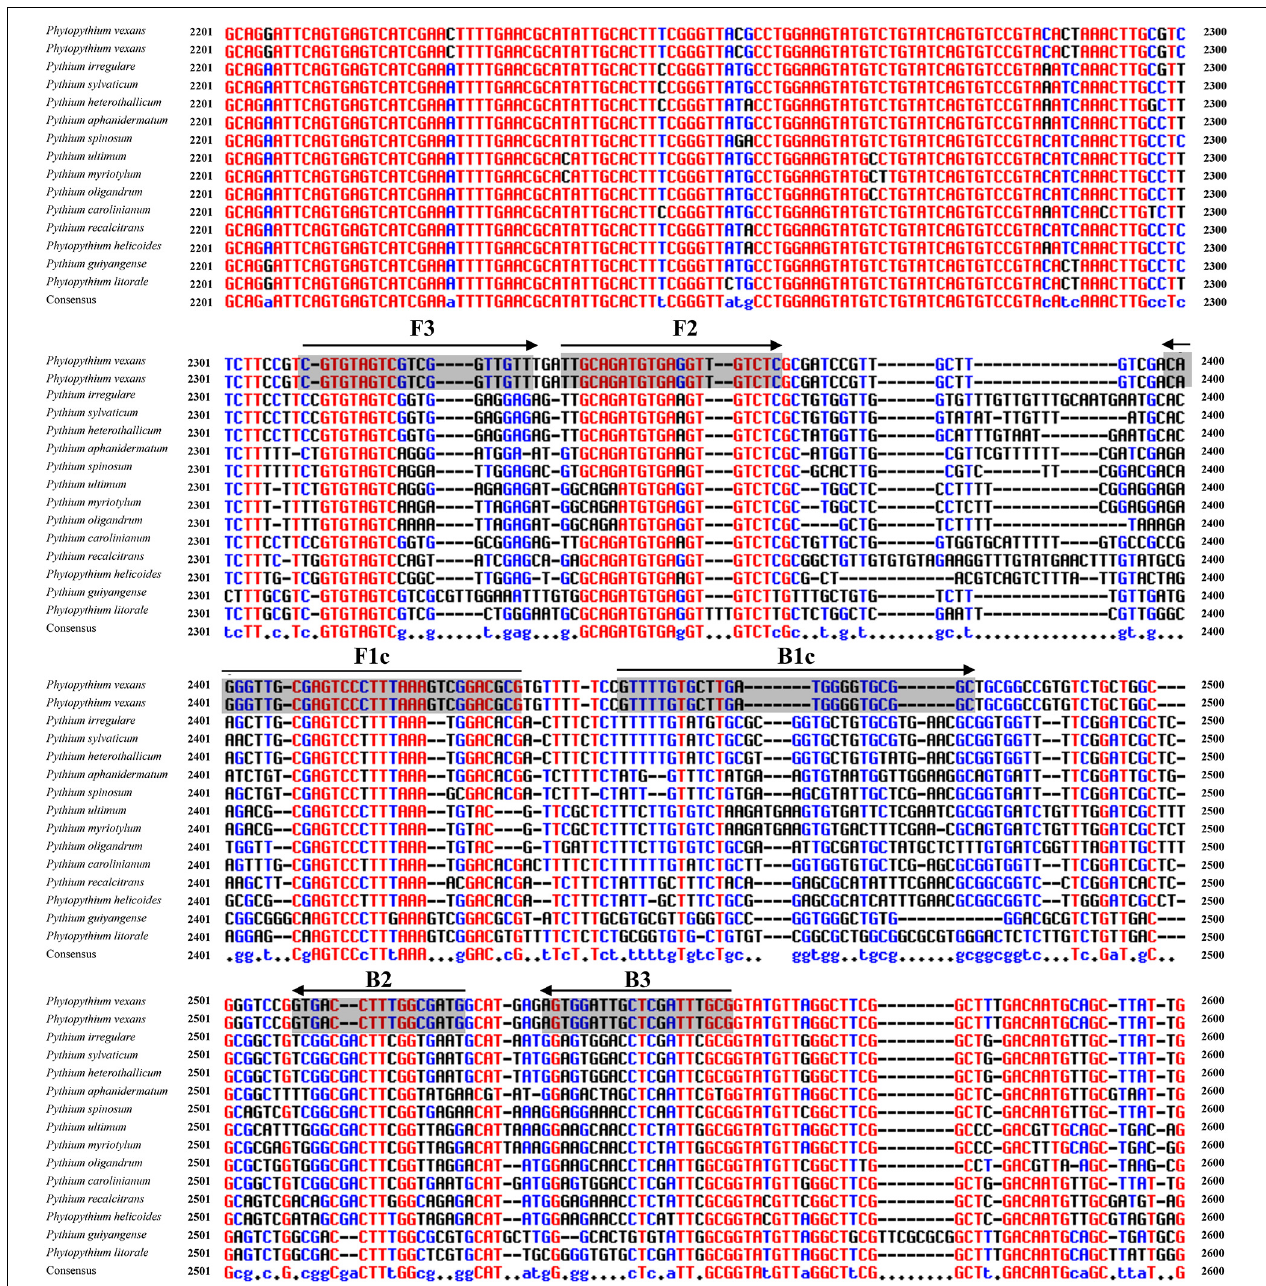
FIGURE 2 | Nucleotide sequence alignment of internal transcribed spacer (ITS) sequences from P. vexans and closely related isolates. Partial sequences of ITS and the location of the Pv8 set consists of four loop-mediated isothermal amplification (LAMP) core primers [Pv8F3, Pv8B3, Pv8FIP (F1c-F2), and Pv8BIP (B1c-B2)] are shown. Arrows indicate the 5 (cid:48) - > 3 (cid:48) direction of primer extension during